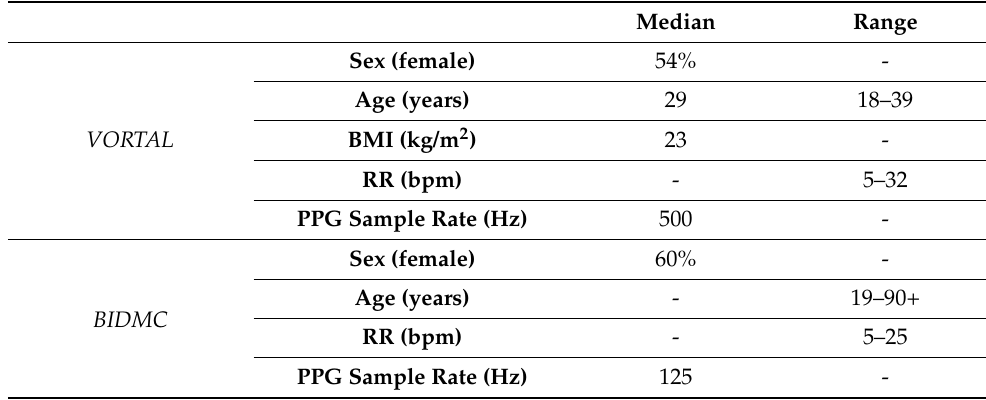
Table 1. Dataset summary of VORTAL and